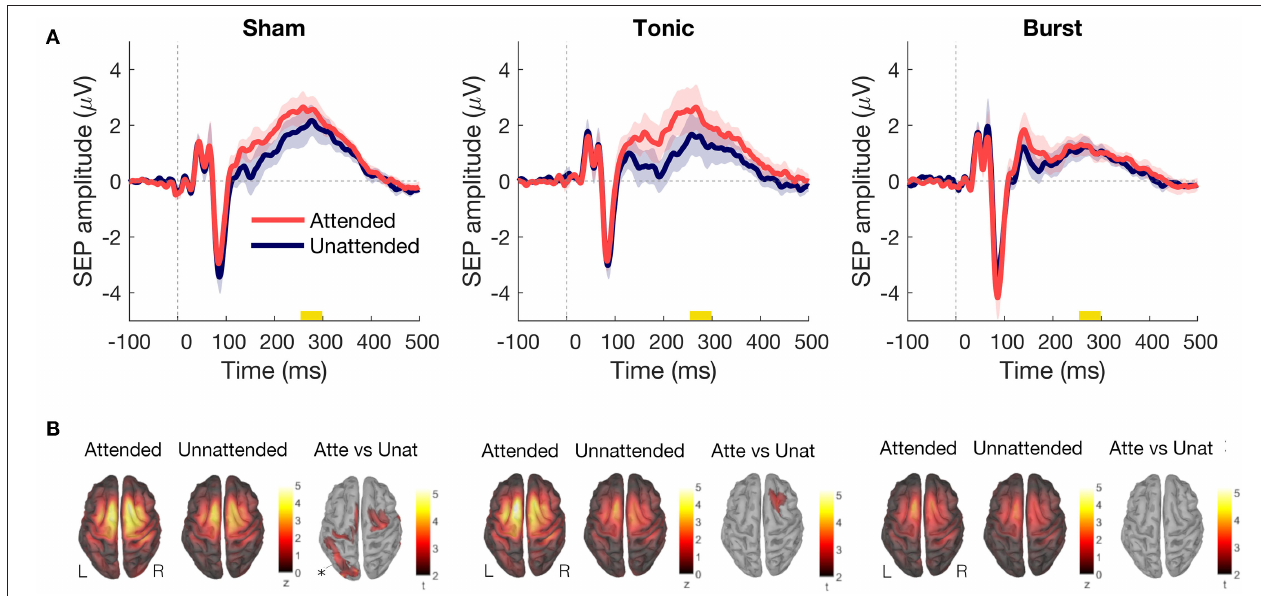
FIGURE 2 | (A) Difference in somatosensory evoked potential between attended (red) and unattended (blue) conditions on the vertex for each type of spinal cord stimulation (SCS): sham SCS (left), tonic SCS (middle), and burst SCS (right). Shadows indicate standard error of the mean (200 epochs per condition, n = 12